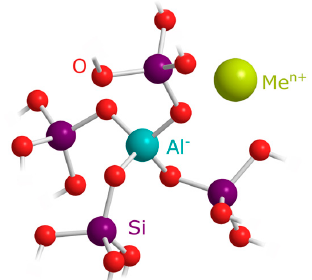
Figure 2. Structure of aluminum in the silica framework with Me n+ as counter ion; model adapted from [47].